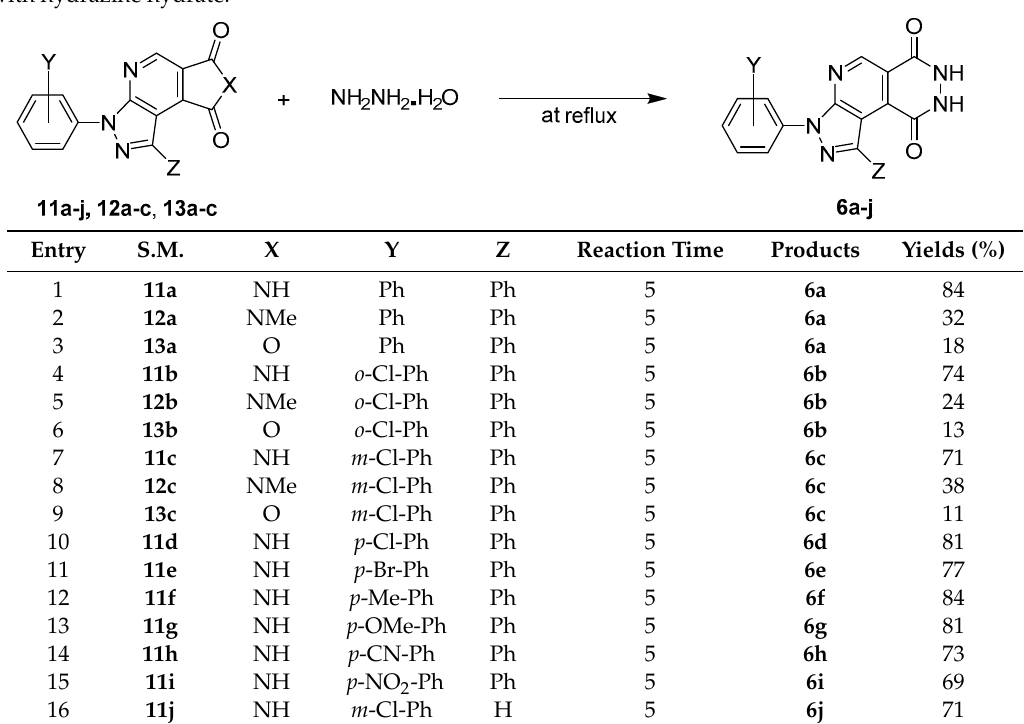
Table 1. The results of pyrazolopyridopyridazine diones 6a – j from reactants 11a – j , 12a – c , or 13a – c with hydrazine